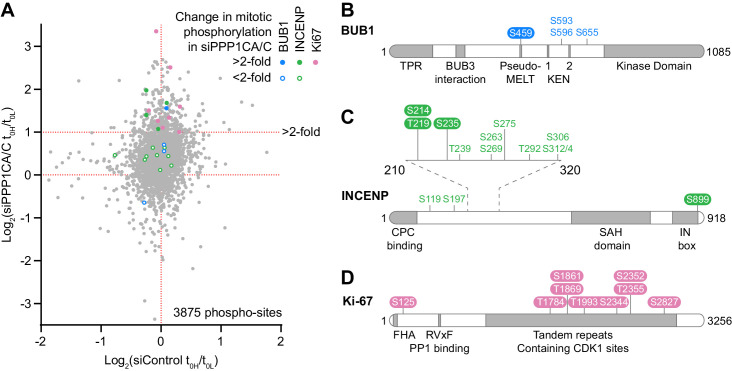
Depletion of PP1 increases the steady-state level of a subset of mitotic phosphorylations.(A) Scatter plot showing the distribution of starting ratios for individual phosphorylated peptides in Control and PPP1CA/C depleted conditions. Heavy/light ratios were logged to base two prior to plotting. Phosphorylated-sites from selected proteins where the starting ratio more than doubled following PPP1CA/C depletion are highlighted with filled circles (BUB1, blue; INCENP, green; Ki-67, pink). Phosphorylated-sites where the ratio did not double are marked with unfilled circles. For clarity, not all sites in Ki-67 are marked. Schematics of (B) BUB1, (C) INCENP and (D) Ki-67 marking the position of phospho-sites highlighted in (A) relative to domains within the protein. Colours, corresponding to those from (A), denote whether the steady-state level of each site was doubled or not following PPP1CA/C depletion. CPC, chromosomal passenger complex; FHA, forkhead-associated domain; KEN, KEN box degron motif; MELT, MPS1 phosphorylation motif; SAH, single α-helix; TPR, tetratricopeptide repeat.